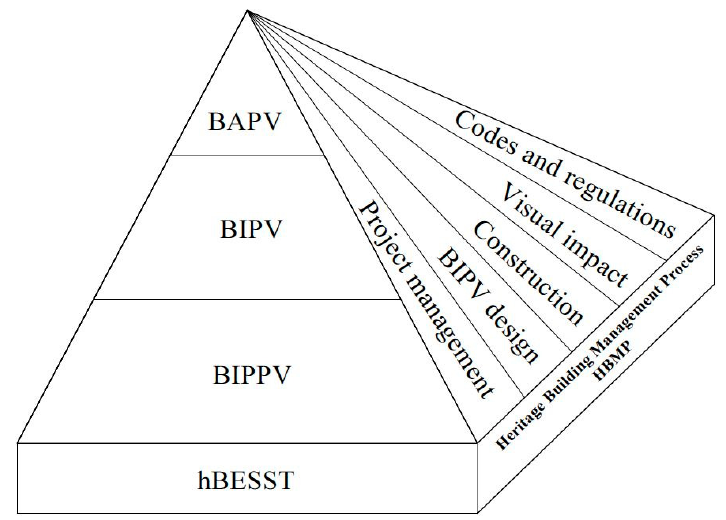
Figure 10. Bottom-up approach schematization of the hBESST procedure.